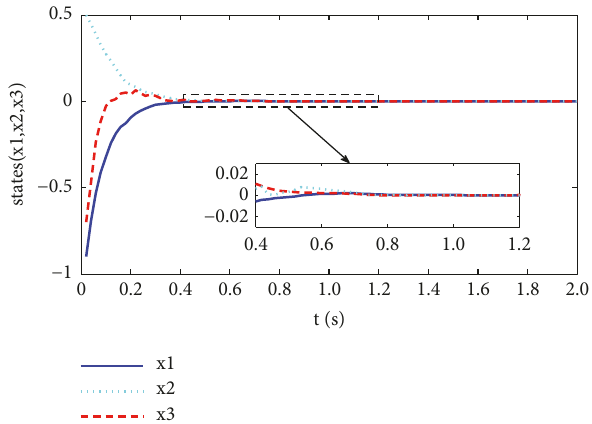
Figure 3: System state trajectory with the proposed